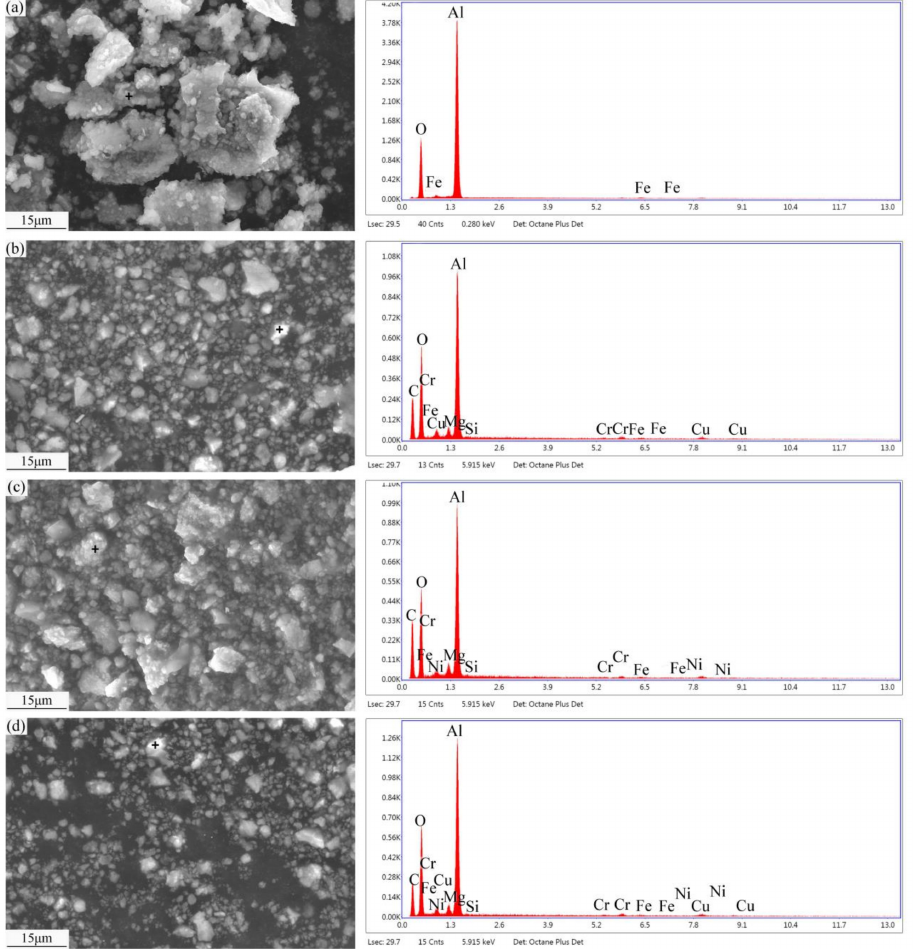
Figure 12. SEM images and EDS patterns of wear debris: ( a ) Al6061 alloy; ( b ) Cu-Cf / Al; ( c ) Ni-Cf / Al; and ( d ) Cu-Ni-Cf /